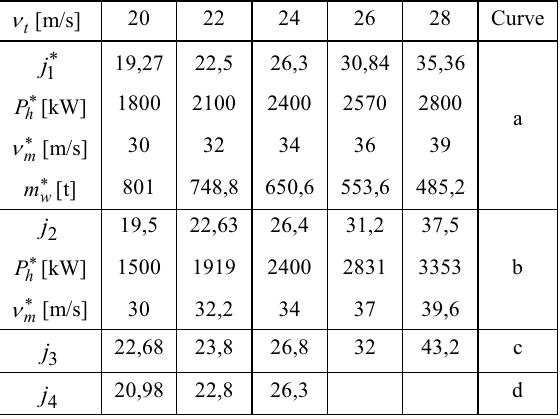
Table 2. Variation of the unitary energy